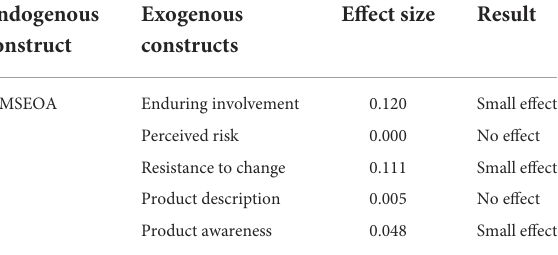
TABLE 9 Effect size of exogenous